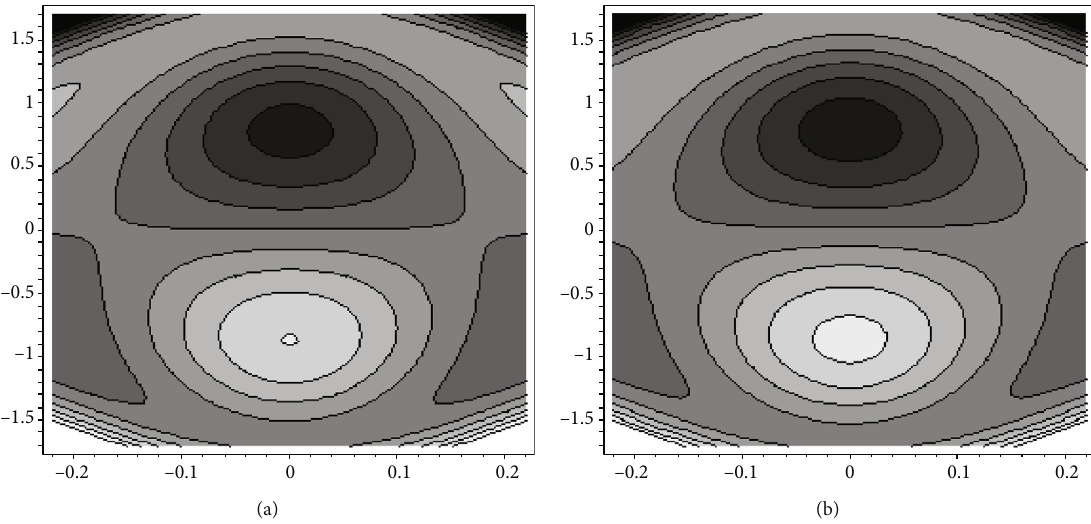
Figure 21: Stream lines for di ff erent values of n . The other parameters are φ = 0 : 7 , β = 4 , We = 0 : 51 , y = 1 , and Q = 2 : 0